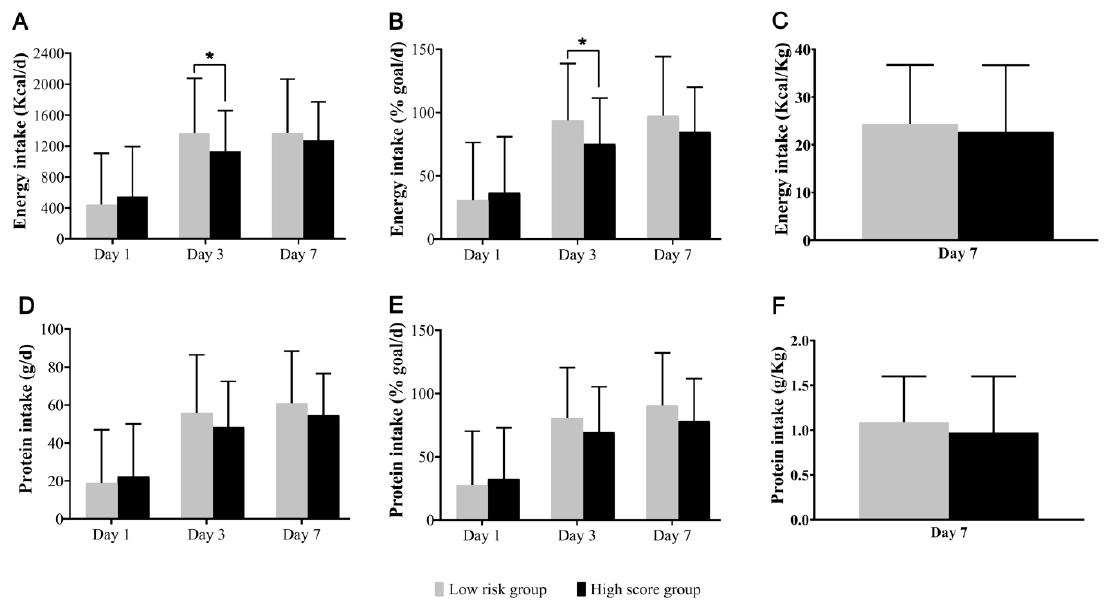
Figure 1. Energy and Protein Intake according to modified NUTRIC score. ( A , D ) show the total amounts of energy and protein received on day 1, 3, and 7. ( B , E ) show the percentage of reaching amounts in whom the target of 25 kcal (energy) and 1.2 g (protein) per kilogram of body weight per day was achieved. ( C , F ) show the total amounts of energy and protein received per kilogram of actual or estimated body weight at day 7; data are presented as means and standard deviation. * p -value < 0.05).